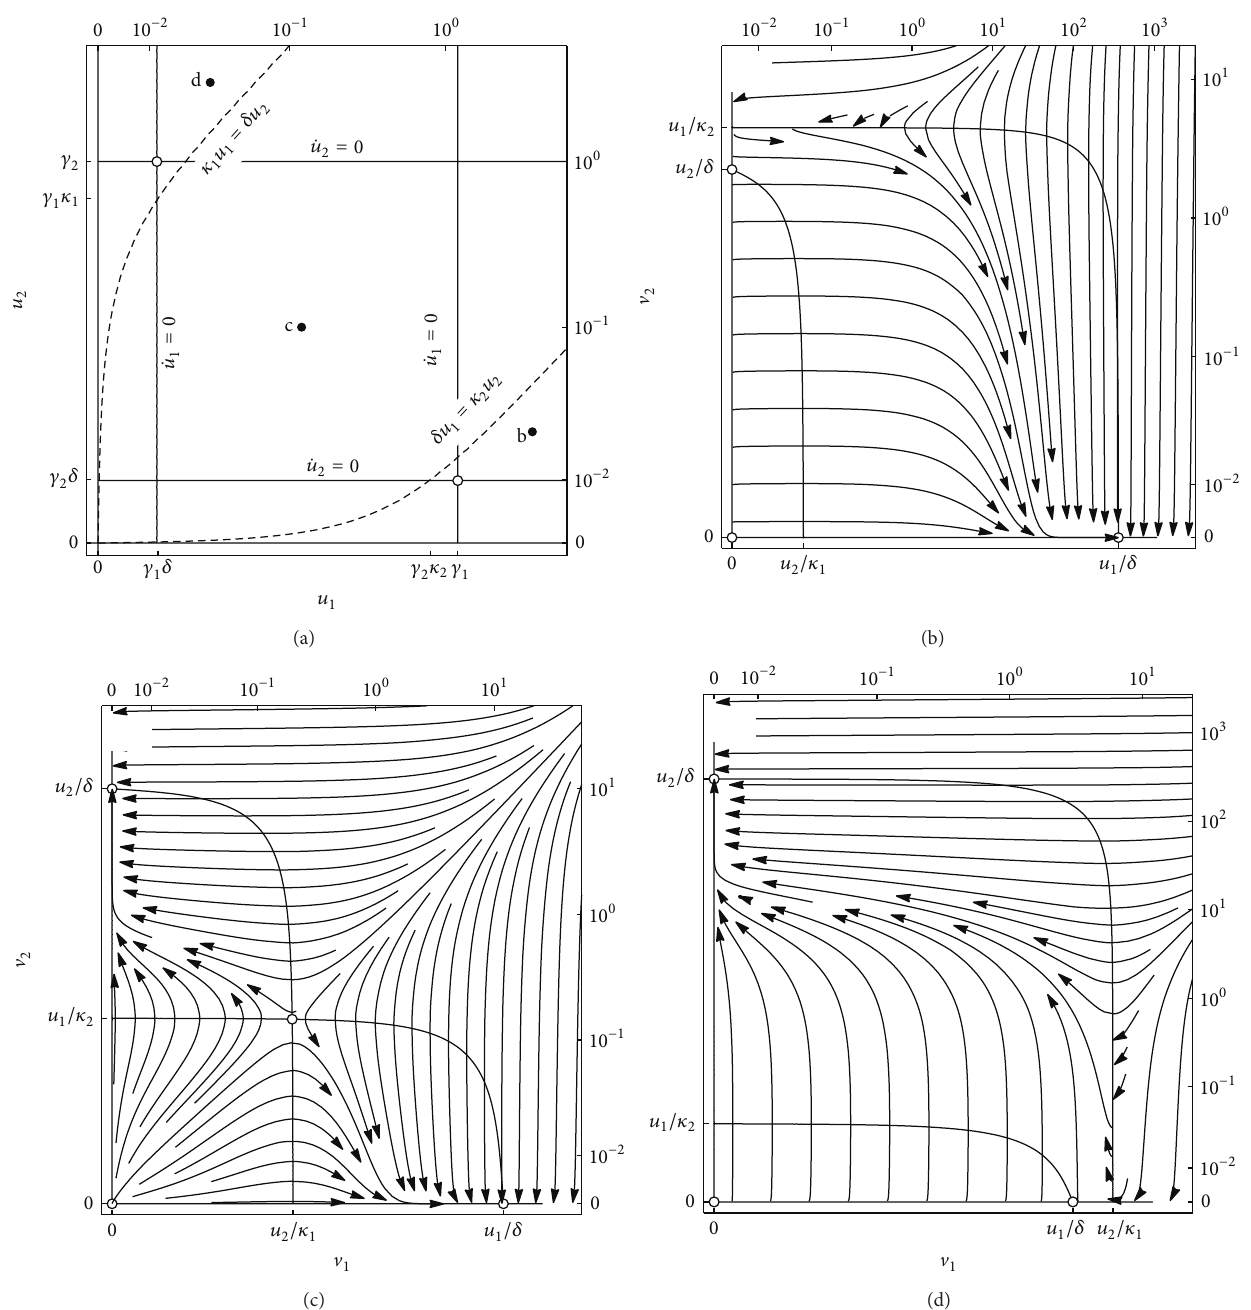
Figure 5: (a) Phase plane of the slow subsystem (43a)–(43d) sectored (by dashed lines) into stability domains of the corresponding quasi- steady states of the fast subsystem (42a)–(42c). Both boundary quasi-steady states, each corresponding to the situation when either of the two consumers completely dominates, are stable within the opening of the angle formed by the dashed lines. Lines 𝑢 1 = 𝛾 1 𝛿 and 𝑢 2 = 𝛾 2 are the respective nullclines ̇𝑢 1 = 0 and ̇𝑢 2 = 0 of the piecewise subsystem (47a)-(47b). Lines 𝑢 1 = 𝛾 1 and 𝑢 2 = 𝛾 2 𝛿 mean the same for the piecewise subsystem (52a)-(52b). Intersections of the nullclines (marked by the open circles) are equilibria of the associated piecewise slow subsystems, and they must lie outside the above-mentioned opening to allow for the relaxation oscillations. (b), (c), and (d) are the respective phase portraits of the fast subsystem (42a)–(42c) generated by points “b,” “c,” and “d” in the slow phase plane